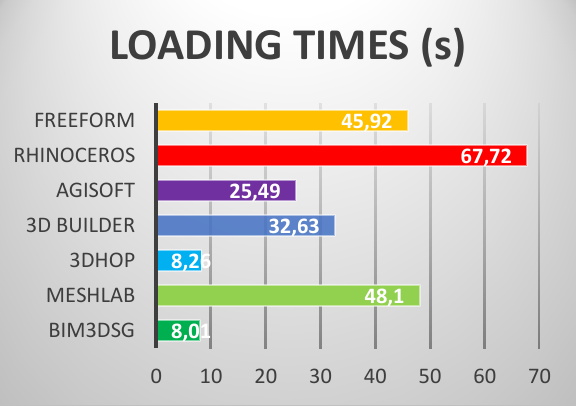
Figure 9: Loading of Umm al-Dabadib’s Forte; lower is better Agisoft is then set as the reference (100%) of loading times (Figure 10), because it is the software with which the model is created. BIM3DSG takes only the 31,42%, thus is 650% better respect Agisoft, 573% better respect Geomagic Freeform Plus and 845% better respect